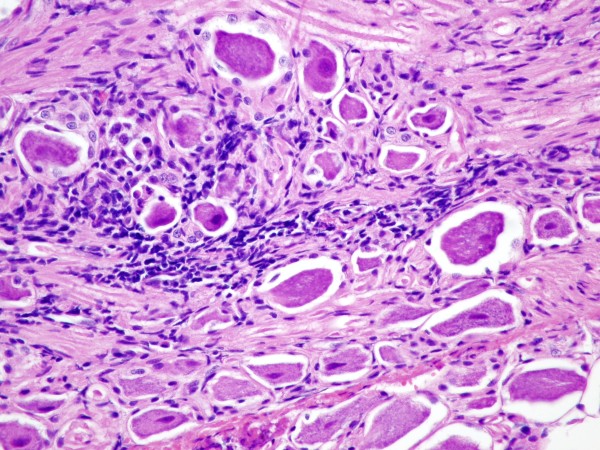
Histologic section of the trigeminal ganglion. Hematoxylin and eosin stained section of the trigeminal ganglion taken at 400X magnification. Note the lymphoplasmacytic inflammation surrounding the neurons.